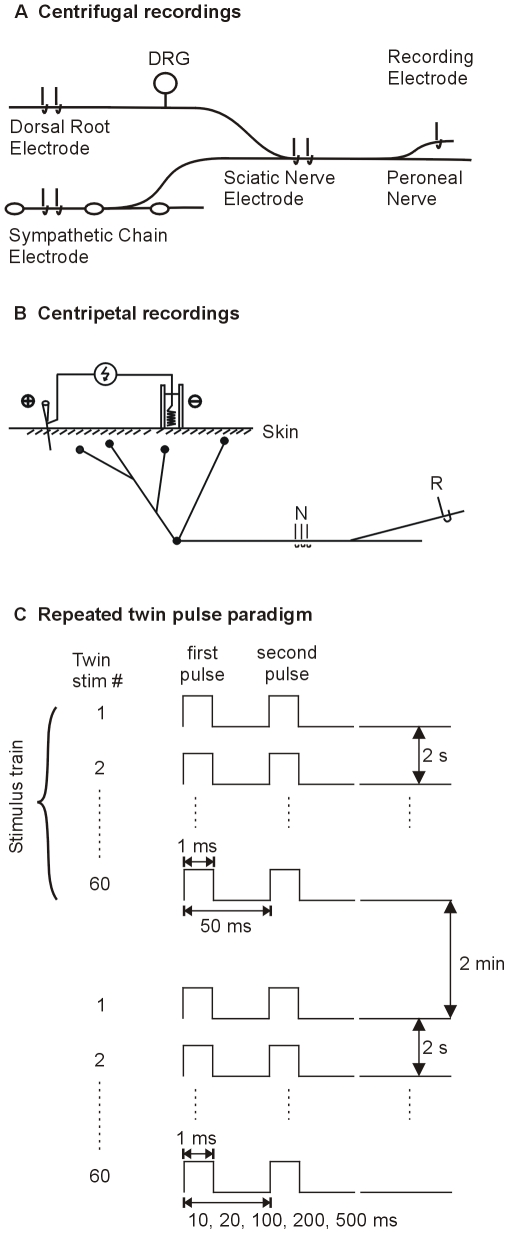
Schematic of electrophysiological preparation.
A) Teased fiber techniques were used to record action potential activity in single C fibers in the peroneal nerve. The latencies of centrifugally propagating action potentials were obtained following electrical stimulation of the sciatic nerve. Collision techniques with stimulation at the sympathetic chain and the sciatic nerve or the dorsal root and the sciatic nerve were used to identify the peroneal nerve fiber as a sympathetic efferent fiber or a sensory afferent fiber. Only sciatic nerve fibers that were positively identified as efferent or afferent were studied. B) Schematic drawing of the transcutaneous electrical stimulation set up used in the centripetal recordings. Plastic wells were glued onto the skin over the receptive field of the unit under study and filled with electrode gel. A silver wire was inserted into the gel and connected to an electrical stimulator. A needle inserted outside the receptive field but nearby served as a return electrode. In some cases, the receptive field was stimulated with two ball electrodes (spacing  = 1 cm). In addition to the skin electrode, an electrode was also placed on the nerve trunk (N) between the peripheral receptive field and the recording electrode (R). C) A repeated twin-pulse stimulation protocol was used in the centripetal recording experiments. The first stimulus train consisted of 60 twin pulse stimuli; 50 ms separated the first and second pulse, and there was a 2 s interval between twin pulses. After a 2 min pause, additional twin pulse trains were delivered in which the interpulse interval was 10, 20, 100, 200, or 500 ms.